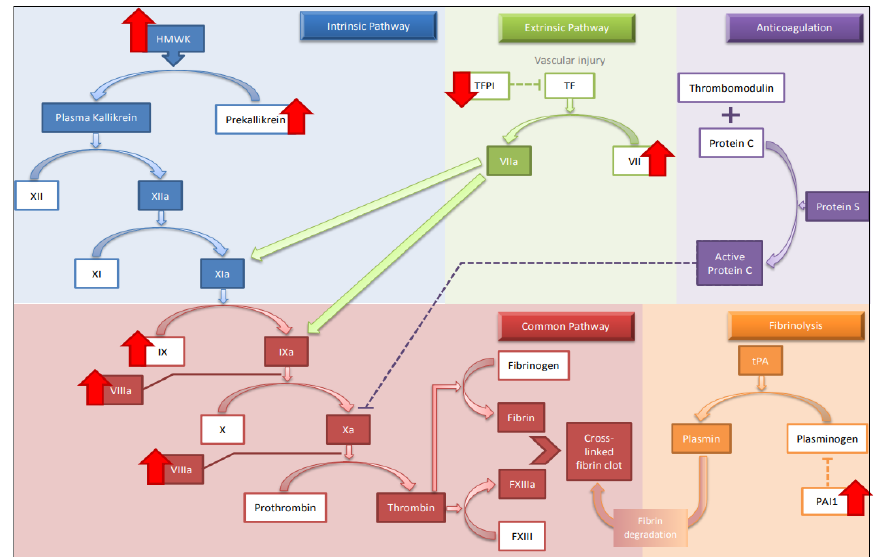
Figure 2. Main changes in the coagulation cascade associated with aging. Abbreviations: HMWK, high-molecular-weight kininogen; TFPI, tissue factor pathway inhibitor; TF, tissue factor; tPA, tissue plasminogen activator. ↑ : up-regulation, ↓ :